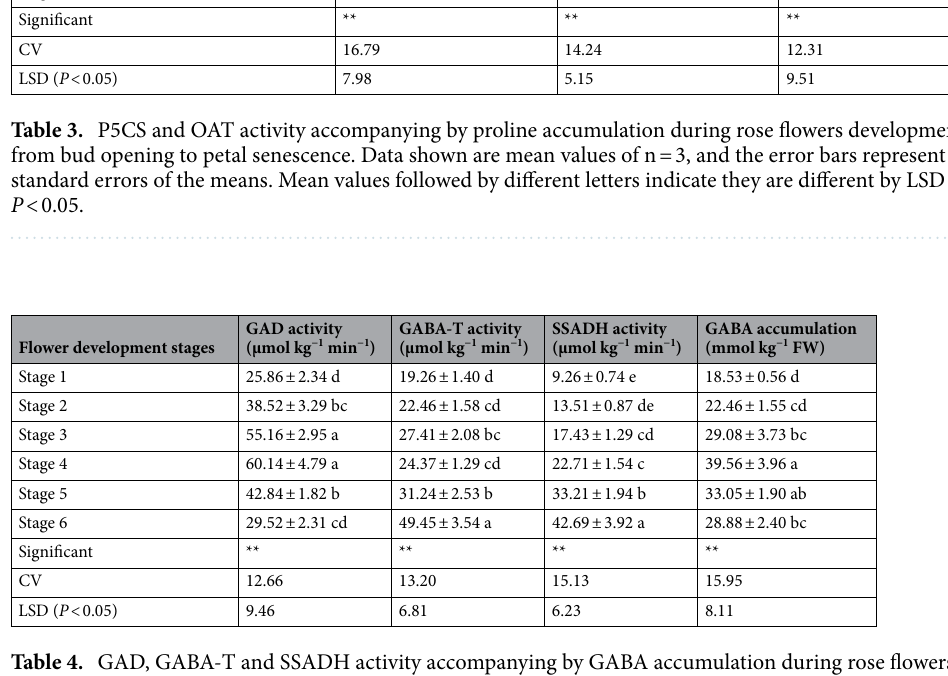
Table 4. GAD, GABA-T and SSADH activity accompanying by GABA accumulation during rose flowers development from bud opening to petal senescence. Data shown are mean values of n = 3, and the error bars represent standard errors of the means. Mean values followed by different letters indicate they are different by LSD test at P < 0.05.